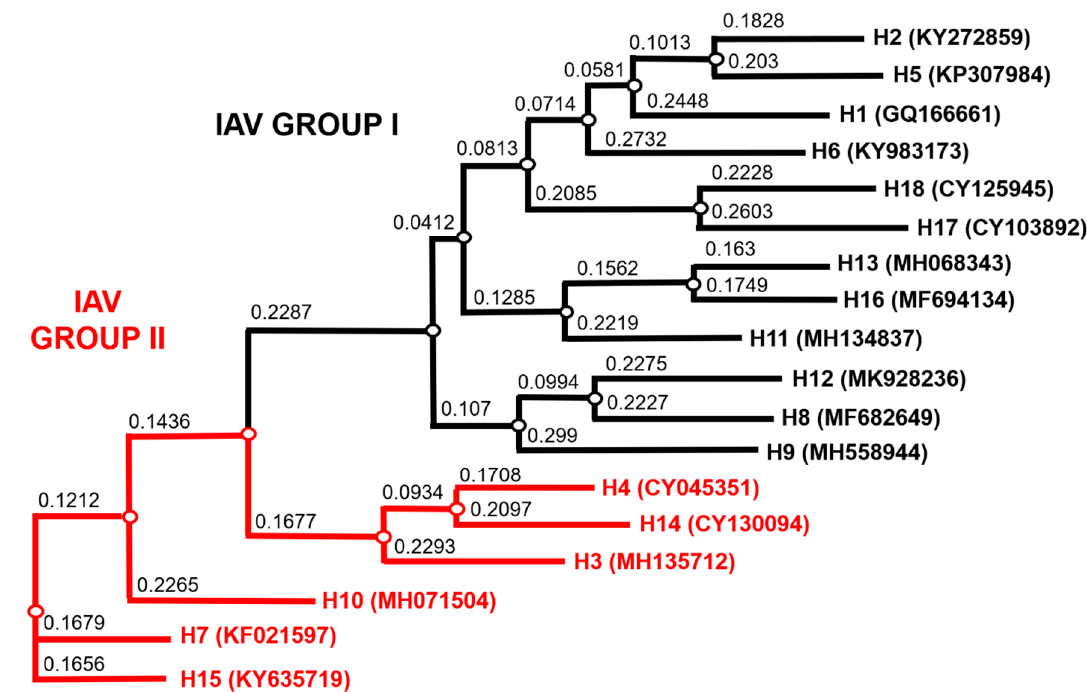
Figure 4. Phylogenetic tree of representative IAV HA from the PV library constructed as shown in Figure 3 and Table 3.